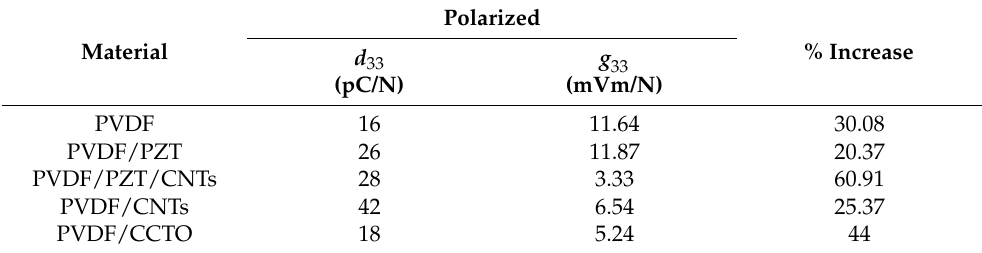
Effect of polarization in enhancing piezoelectric strain and voltage coefficient of the